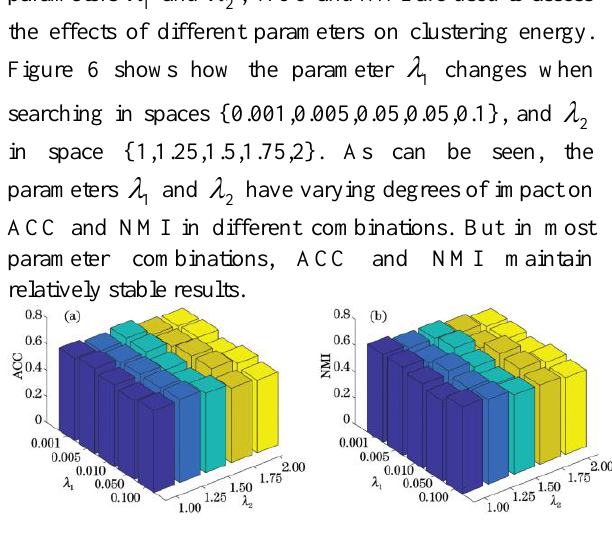
Figure 5. Distribution visualization of embedded subspaces of different strategies on the MNIST dataset. (a) ConvAE; (b) ConvAE+MI; (c) ConvAE+GCN; (d) ConvAE+ MI+GCN